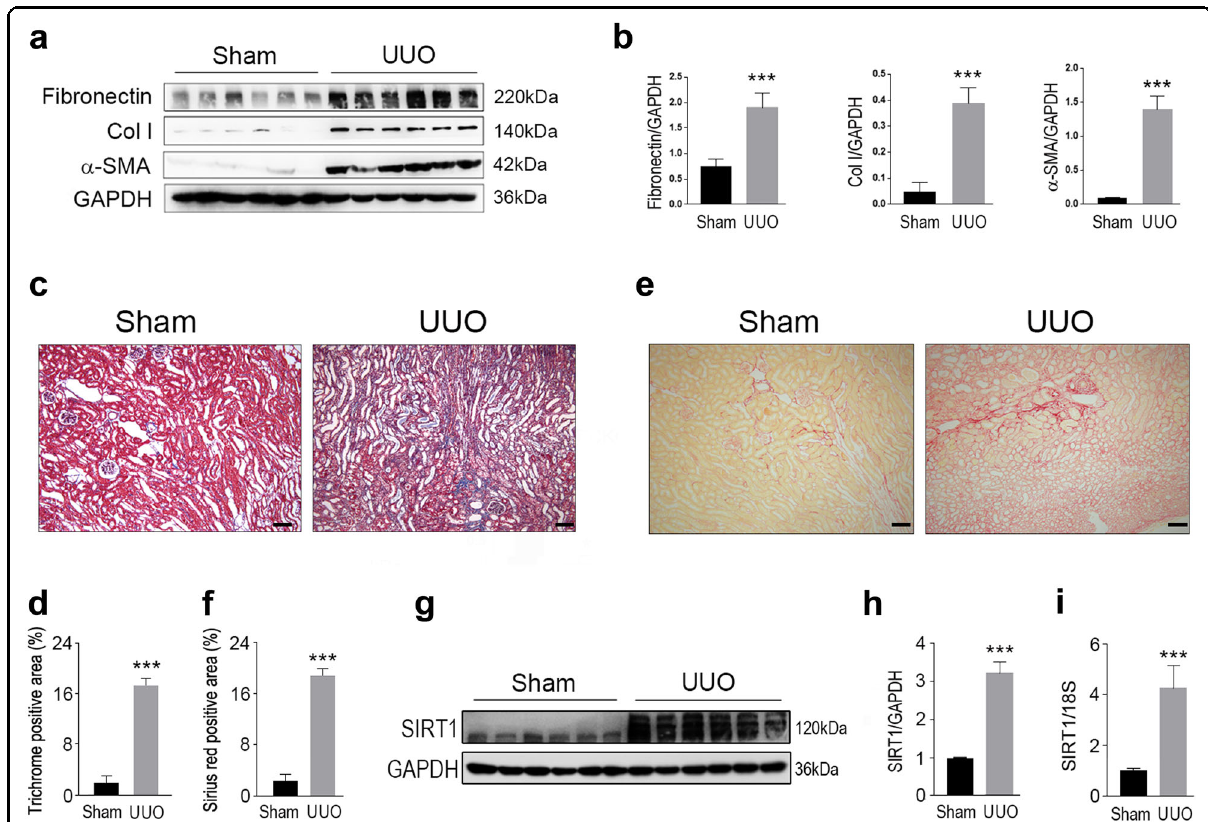
Fig. 1 SIRT1 is upregulated in the kidney from UUO modeled mice. Male wild-type C57BL/6 mice, at 8 – 10 weeks of age, were subjected to UUO operation. Mice were euthanized 10 days after sham or UUO surgery. a Western blot analysis showed that fi bronectin, collagen I (Col I), and a-SMA in the kidney were increased upon UUO surgery. GAPDH was used as a loading control. b Quanti fi cation of western blot data as shown in a . c Masson- trichrome staining. Scale bar = 50 μ m. d Quantitative analysis for c . e Sirius red staining. Scale bar = 50 μ m. f Quantitative analysis for e . g SIRT1 in the kidney was enhanced in UUO-operated mice. Protein levels were analyzed by western blot analysis and GAPDH has used a loading control. h Quanti fi cation of western blot data as shown in e . i SIRT1 mRNA levels were increased in the kidney from UUO mice. n = 6. Data are means ± SEM. *** P <